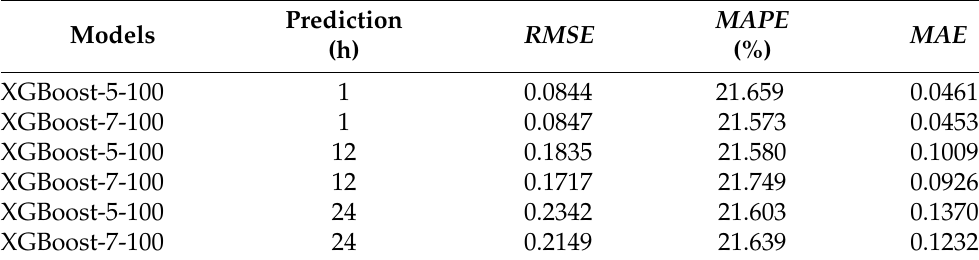
Table 6. RMSE , MAPE , and MAE results for the VSTLF and STLF models.